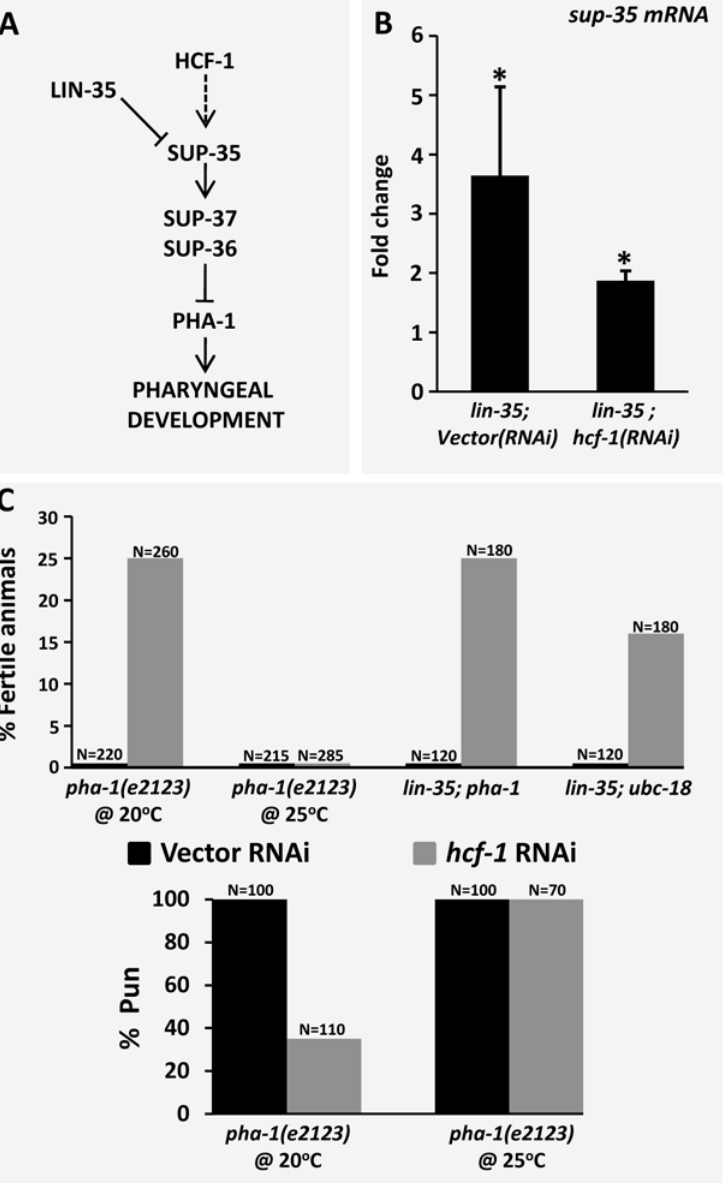
Figure 8. Regulation of sup-35 by HCF-1. (A) Testable model for the regulation of sup-35 by hcf-1 . (B) Quantification of endogenous sup-35 mRNA levels by qRT-PCR in lin-35 and lin-35; hcf-1(RNAi) embryos using act-1 as an internal normalization control. Note that sup-35 mRNA levels drop , 2 fold in hcf-1 (RNAi)-treated lin-35 mutants as compared with vector RNAi-treated lin-35 single mutants. Fold changes were obtained after normalizing to N2. Error bars represent s.e.m and significance was calculated using a two-tailed Student’s t-test (*p , 0.05). (C) Suppression of larval arrest in pha- 1(ts) and synthetic mutants by hcf-1 (RNAi). hcf-1(RNAi) effectively increases the frequency of fertile adults by suppressing the larval lethality of lin- 35;pha-1 and lin-35;ubc-18 double mutants. Similar results were also observed for pha-1(ts) at the intermediate temperature of 20 u C, but not at 25 u C. (D) hcf-1 (RNAi) strongly suppresses the Pun (Pharynx unattached) in pha-1(ts) mutants at 20 u C, but not 25 u C. These results were also duplicated using RNAi injection to target a different region of the hcf-1 transcript (Materials and Methods and data not